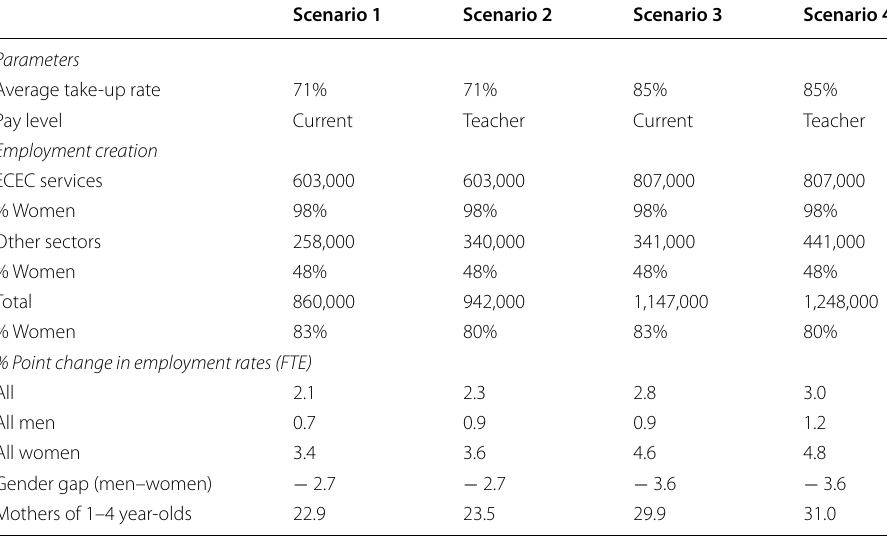
Table 4 Employment created in the childcare industry and more widely by pay